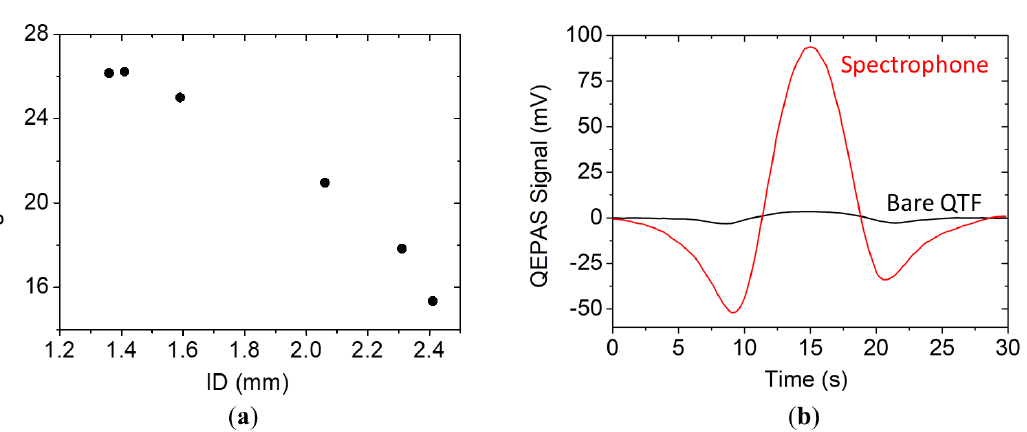
Figure 6. ( a ) Signal enhancement of the spectrophone signal with respect to the bare QTF signal as a function of the tubes’ internal diameter when the optimal tube length was used for each ID . ( b ) QEPAS spectral scan of water absorption line acquired with the bare QTF (black solid line) and with a spectrophone composed of the QTF and a pair of resonator tubes having a length of 9.5 mm and internal diameter of 1.41 mm, both positioned 150 μm away from the QTF surface (red solid line).